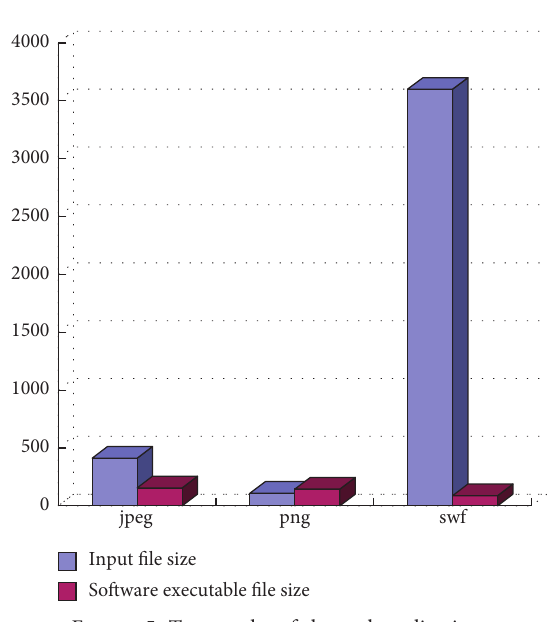
Figure 5: Test results of the real application. Table 2: The number of suspicious instructions and the accuracy of their type